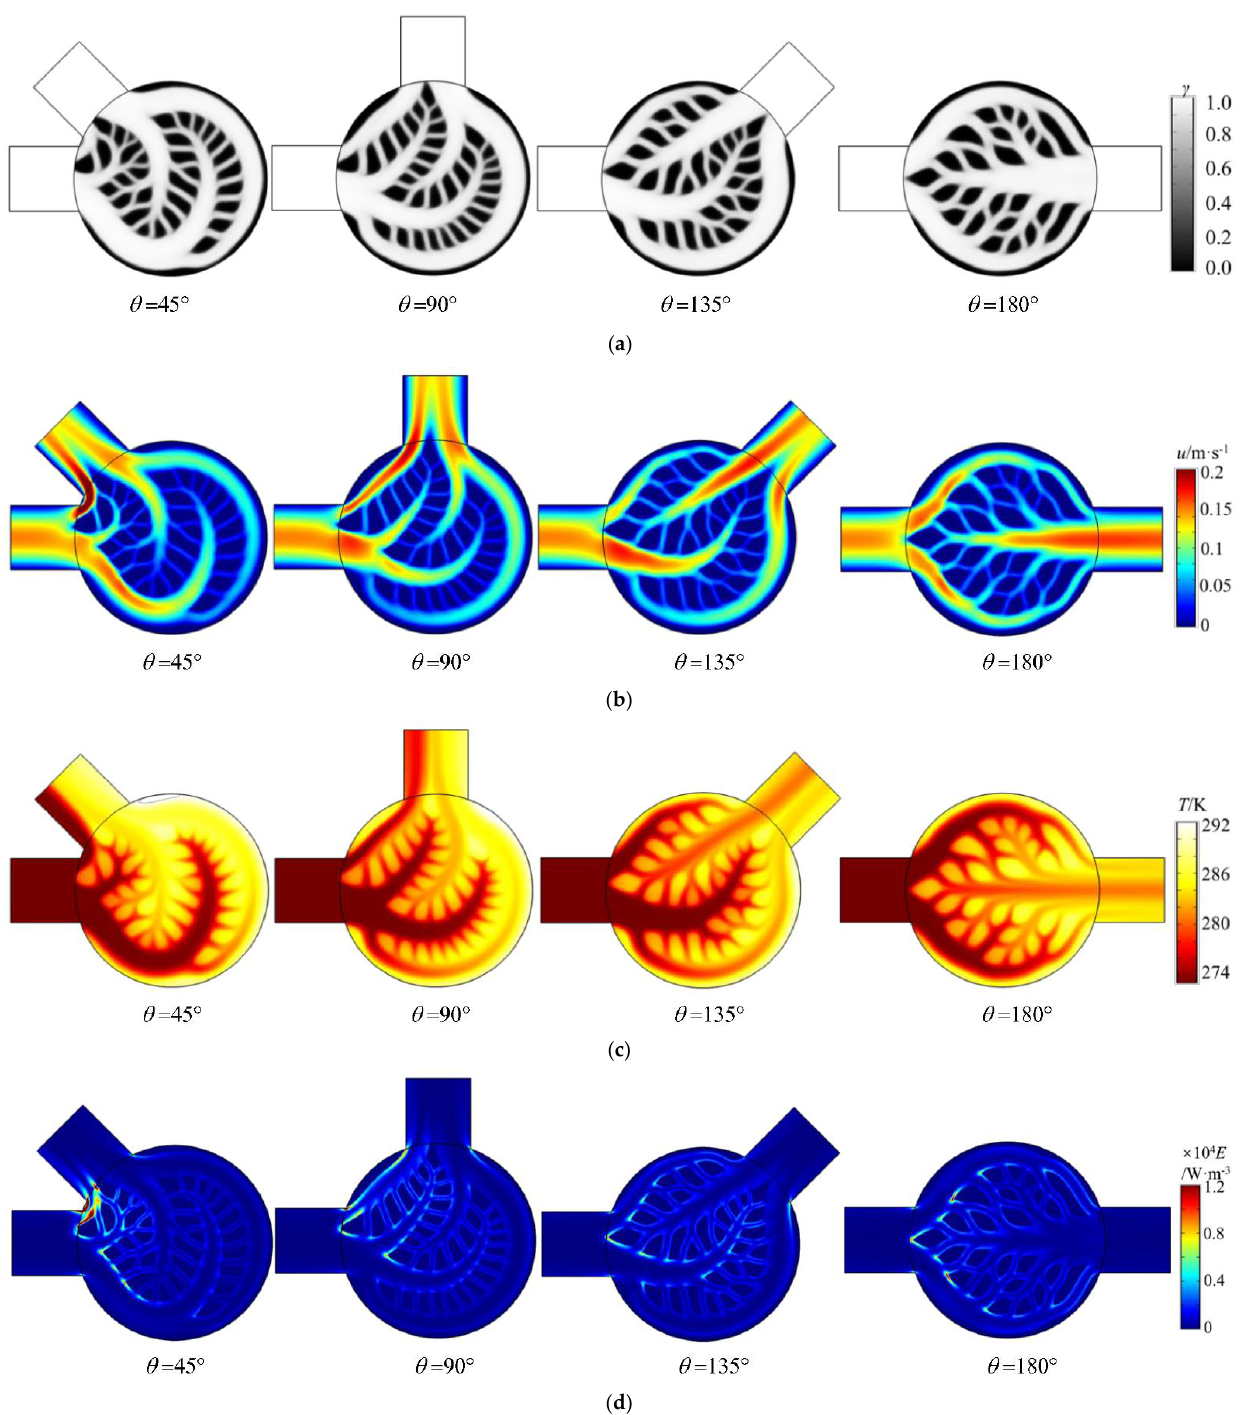
Figure 4. Variation of optimal topology, velocity field, temperature field, and energy dissipation density field distribution with θ . ( a ) Optimal topology; ( b ) Velocity field; ( c ) Temperature field; and ( d ) Energy dissipation density field.